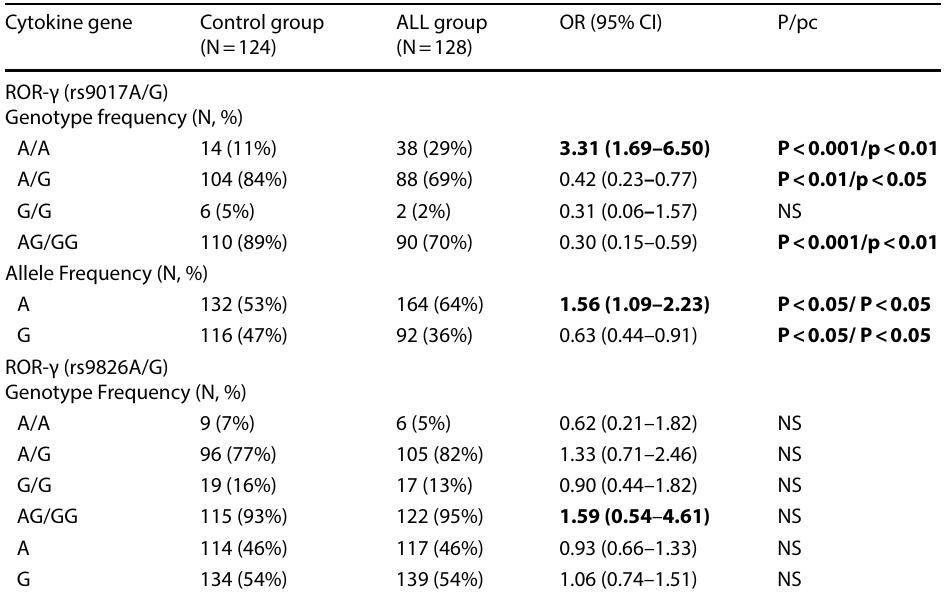
Table 4 Haplotype frequencies of the FOXP3 SNPs (rs3761549C/T and rs3761548C/A) and ROR-γ (rs9017A/G and rs9826A/G) in controls and ALL patients